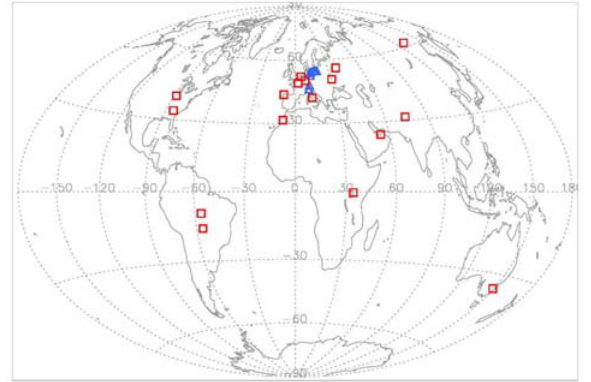
Figure 1. Location of test sites used for these investigations. Red squares mark locations of AERONET sites (global data set) and blue triangles mark locations of own sunphotometer measurements (regional data set).